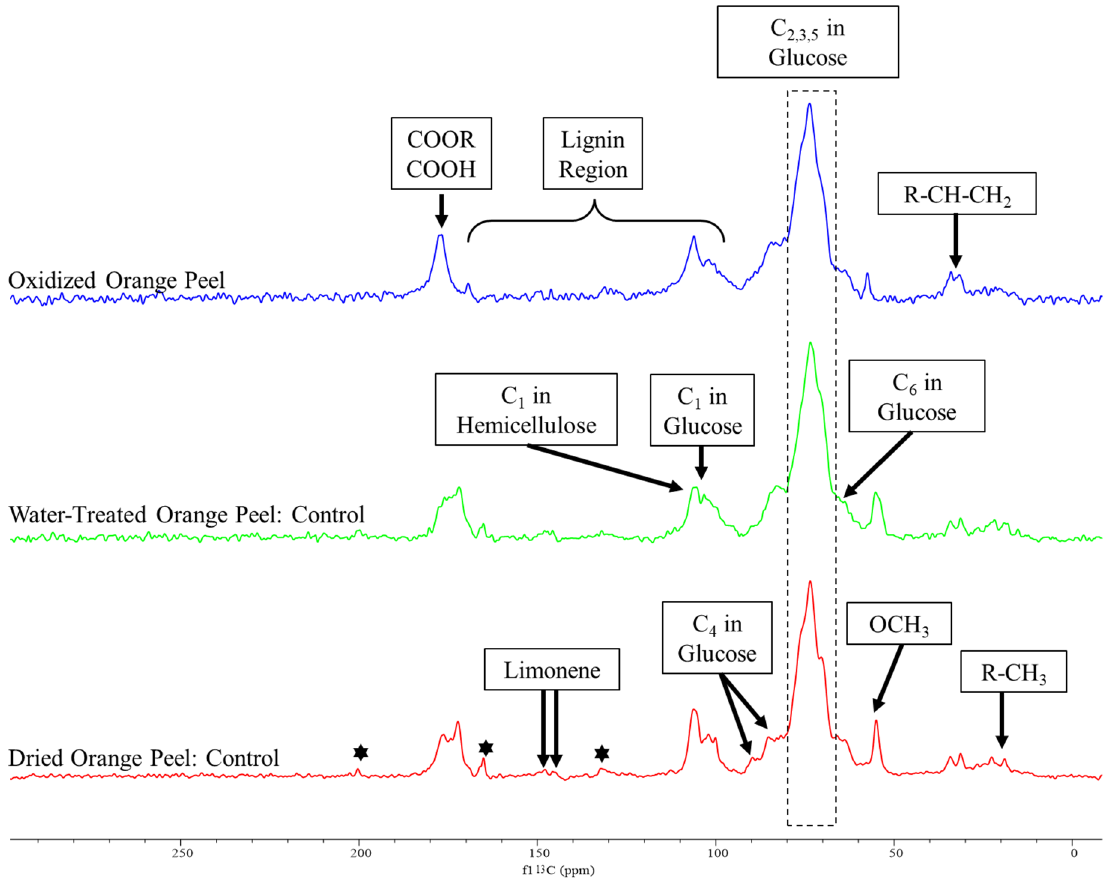
Figure 4. The solid-state 13 C CP/MAS spectrum of dried orange peel, water-treated (to remove soluble sugars from dried powder), and oxidized orange peel. The stars indicate the presence of citral. Peaks associated with cellulose, hemicellulose, pectin, lignin, and essential oils appeared in the spectra of the control samples similar to those reported by Merino et al. [38] and Foston et al. [39]. Changes in peak intensity were modest when spectra of dried powder orange peels were compared with water-treated orange peels. The major difference was the sugar peak intensities which were present, but to a lesser extent for water-treated orange peels. We attribute this reduction to the solubilization of free sugar and its removal during the filtration process. The spectra of both control samples demonstrated the existence of citral, a monoterpene in essential oils, at 200.34, 165.16, and 132.18 ppm [40]. The peaks attributed to citral were reduced in the oxidized orange peel indicating a successful degradation or modification of this component. Additionally, the limonene peaks appeared in dried, water-treated samples (controls), as well as oxidized treated orange peels at 145.85 and 145.09 ppm. The removal of residual limonene from the orange peel liquor after treatment was further confirmed by the DART-MS study (Figure 5 ) . The decrease in cellulose and hemicellulose related peaks for the oxidized orange peel samples at 106.20 and 101.10 ppm (C 1 in glucose unit), 89.70 and 85.20 ppm (C 4 in